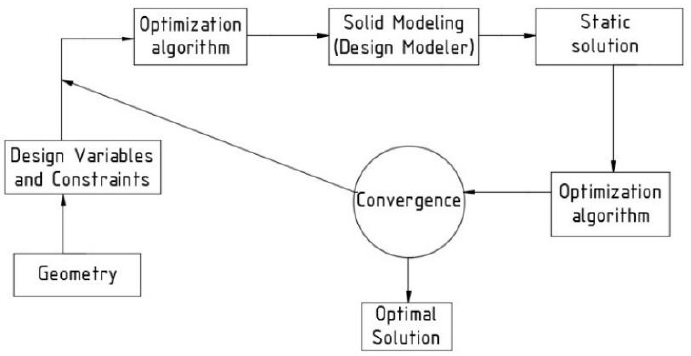
Fig. 3. Traditional approach to MEMS device